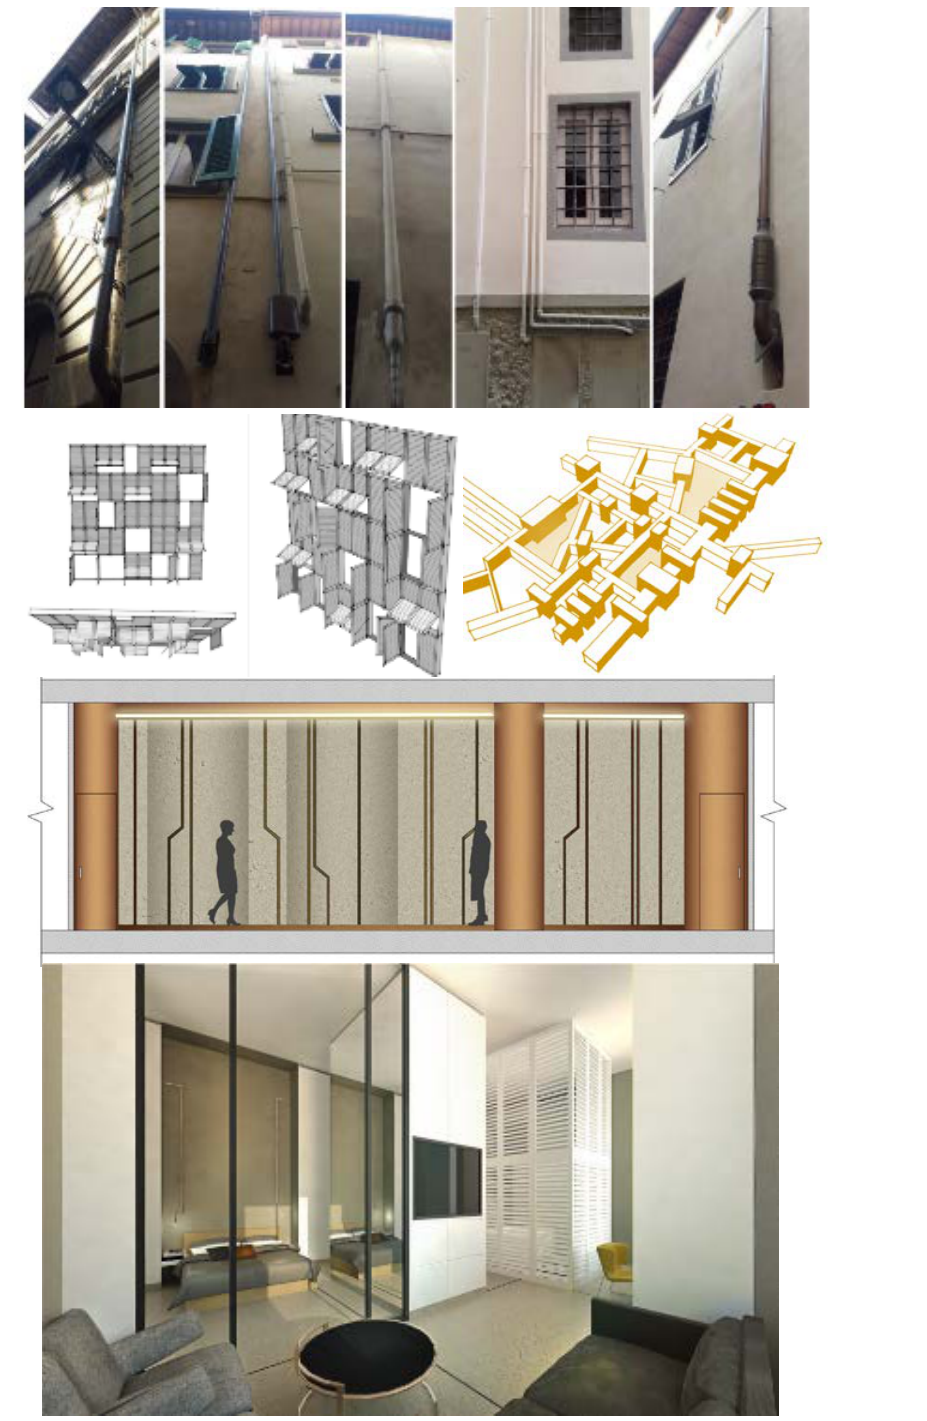
Figure 8 Photo Credits to I.D Hagar